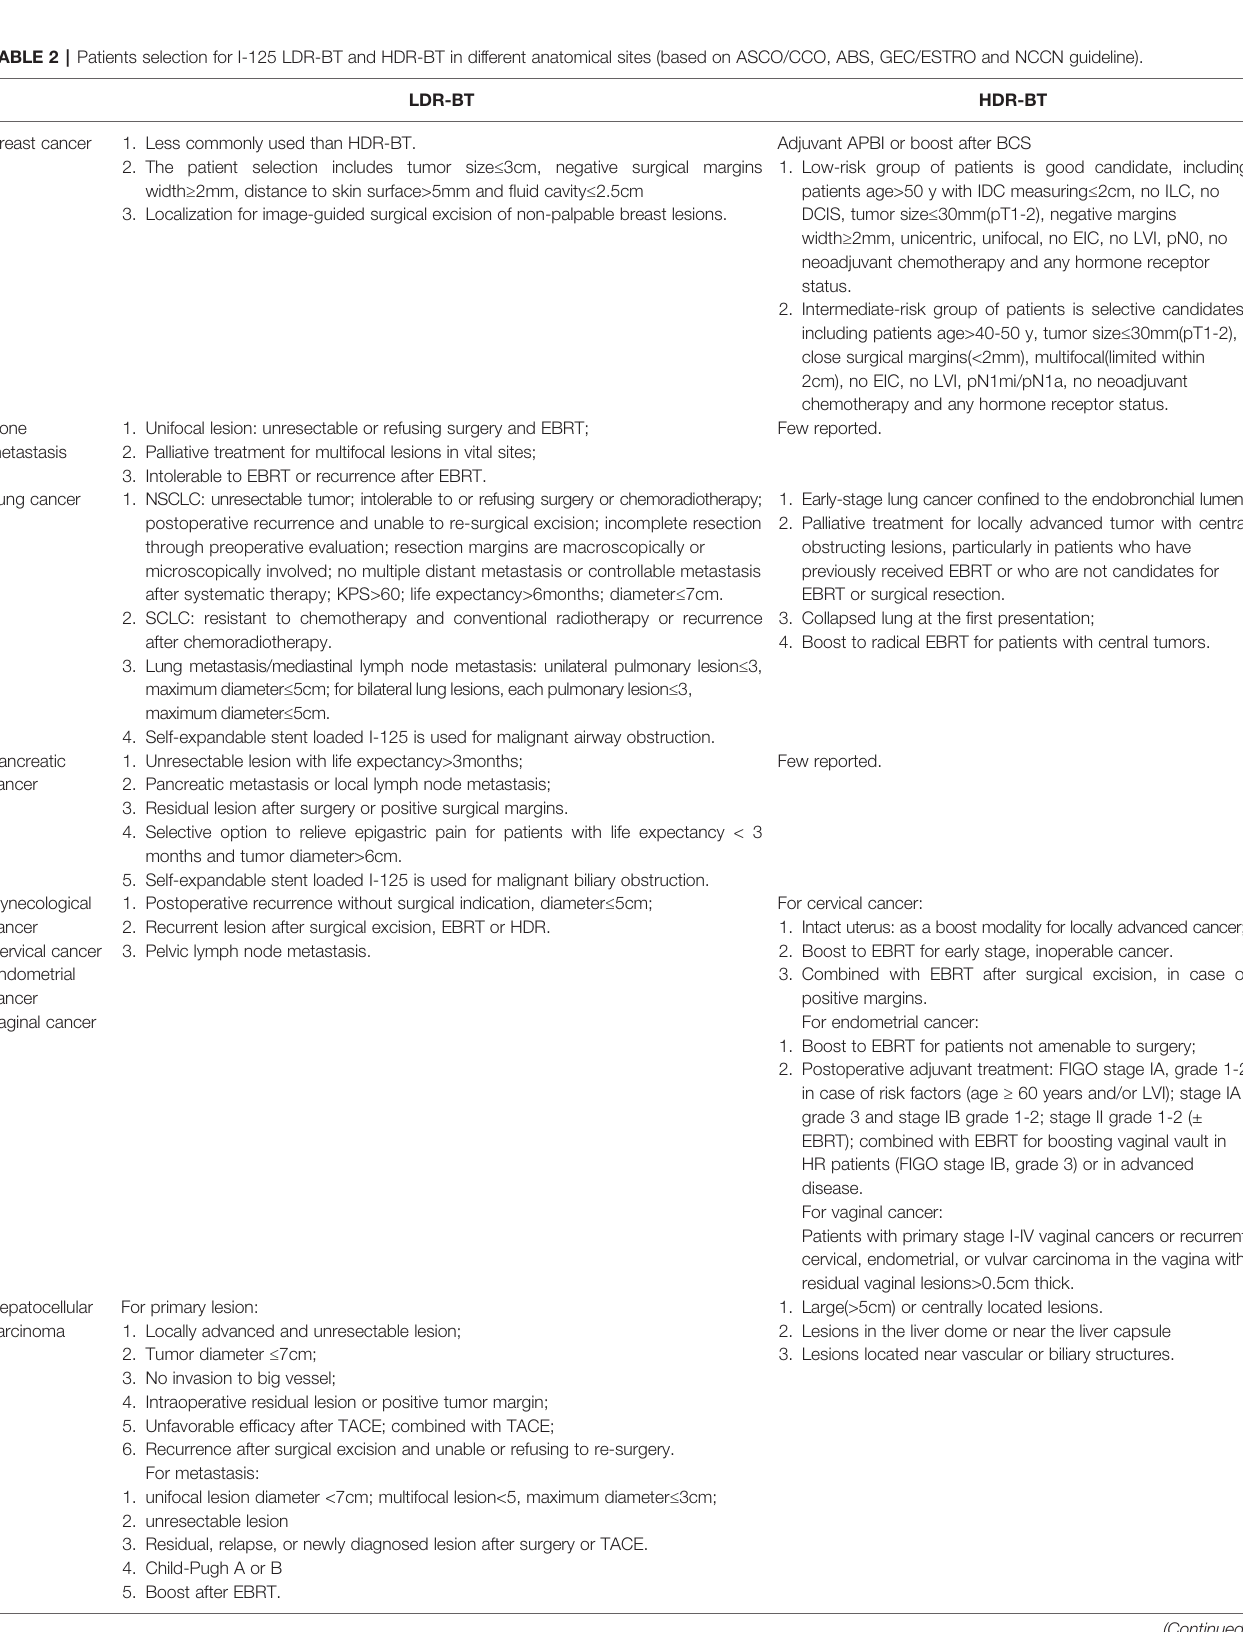
TABLE 2 | Patients selection for I-125 LDR-BT and HDR-BT in different anatomical sites (based on ASCO/CCO, ABS, GEC/ESTRO and NCCN guideline). LDR-BT Breast